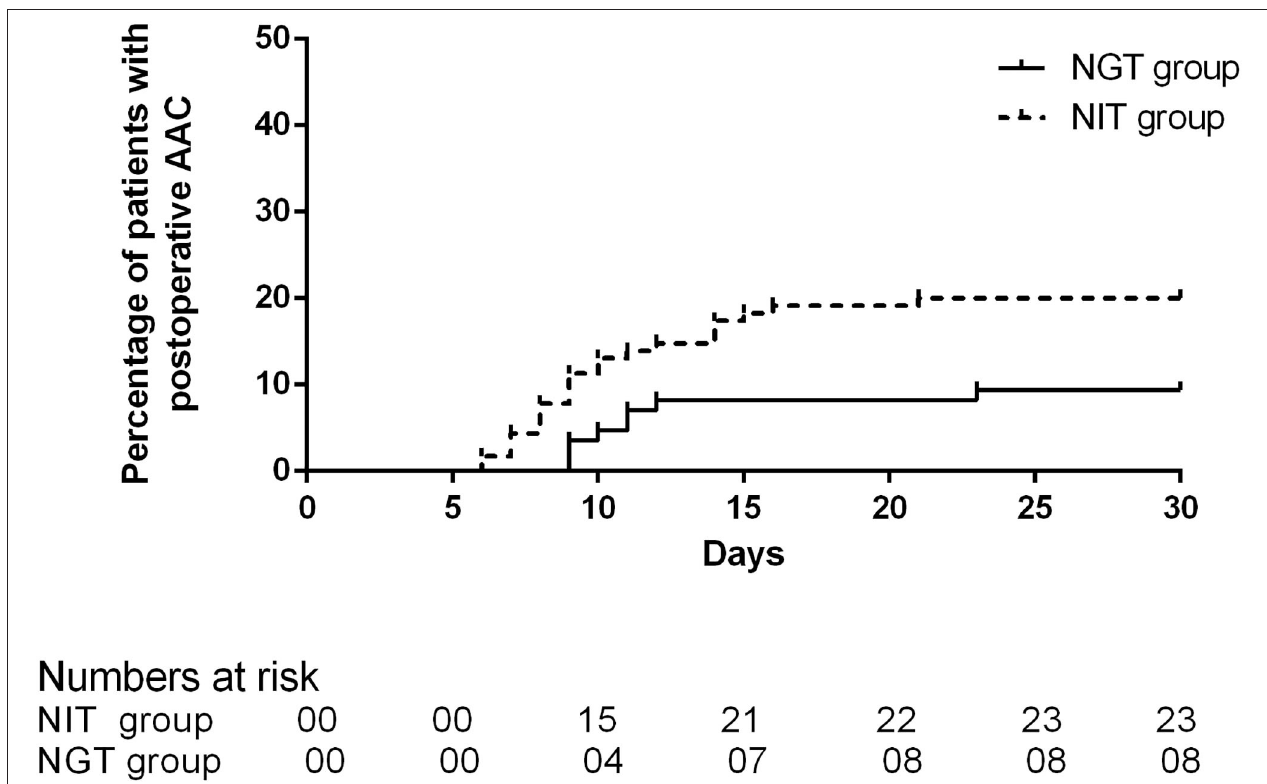
FIGURE 2 | Percentage of patients with post-operative AAC between the two groups.